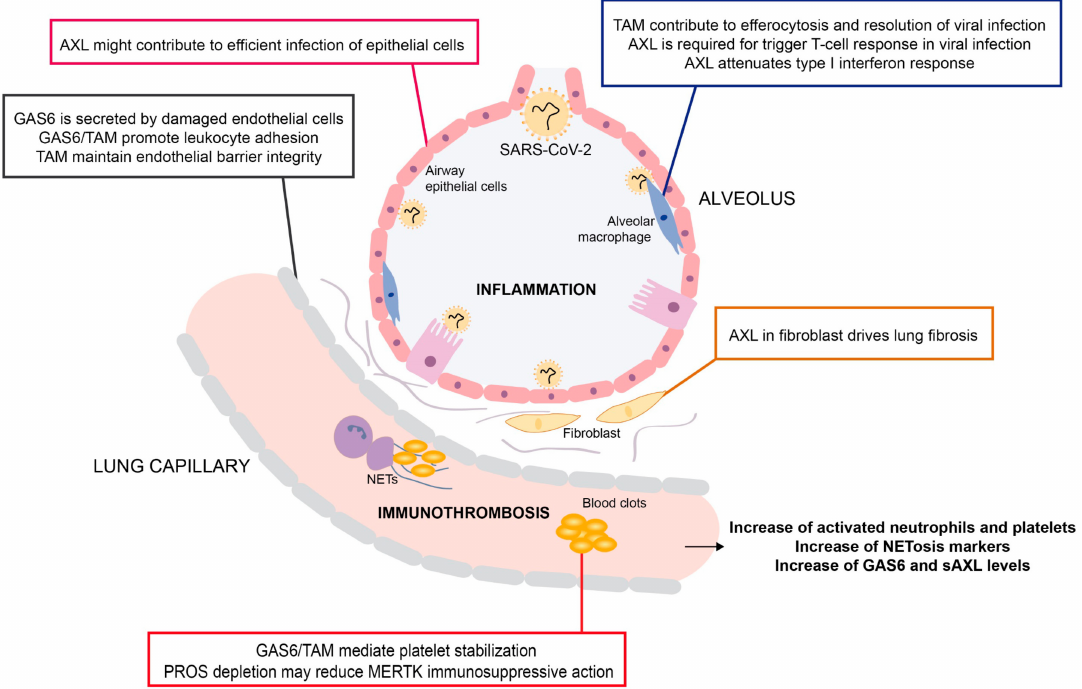
Figure 3. Processes implicated in COVID-19 role with a role of TAM receptors. TAM may have a role at di ff erent levels in COVID-19 pathogenesis. First, in airways, TAM might enhance infection promoting e ffi cient virus entry to epithelial cells and inhibiting anti-viral interferon response. However, TAM could be required for stimulation of adaptive immunity and damage resolution. Of note, relating long-term complications, over-activation of AXL in lung fibroblast can be critical for pulmonary fibrosis development. Second, we suggest an important role of TAM signaling in coagulopathies linked to excessive inflammation observed in COVID-19. TAM regulation of vessel permeability, recruitment of neutrophils and stabilization of platelets may a ff ect immunothrombosis, characterized by neutrophils and platelets activation, neutrophil extracellular traps (NETs) release and clot formation. Interestingly, COVID-19 patients present not only an increase of NETosis markers and activated neutrophils and platelets in blood, but also increased levels of GAS6 and sAXL. Furthermore, a decrease in PROS1 activity would unbalance hemostasis, increasing the risk of local